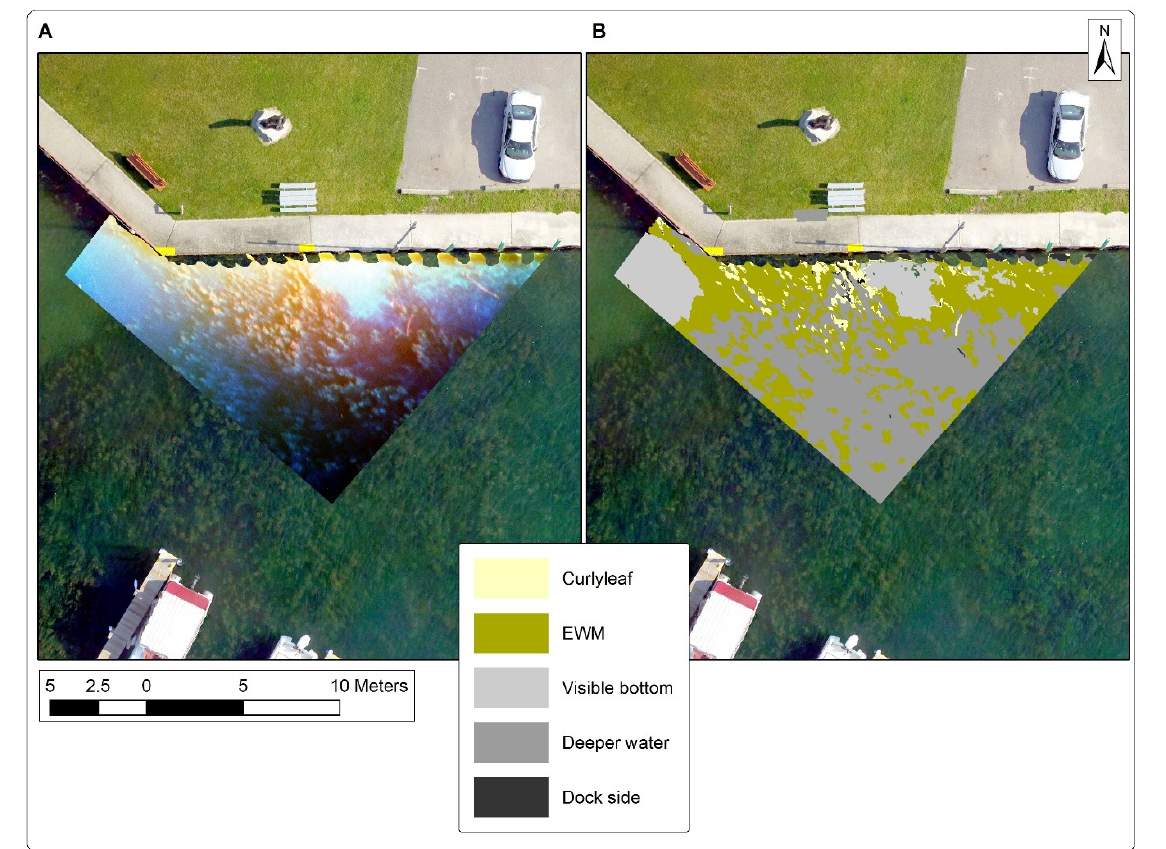
Figure 7. Hessel Marina July 2017 example result, with ( A ) Tetracam imagery and ( B ) classification result with scale parameter = 25.